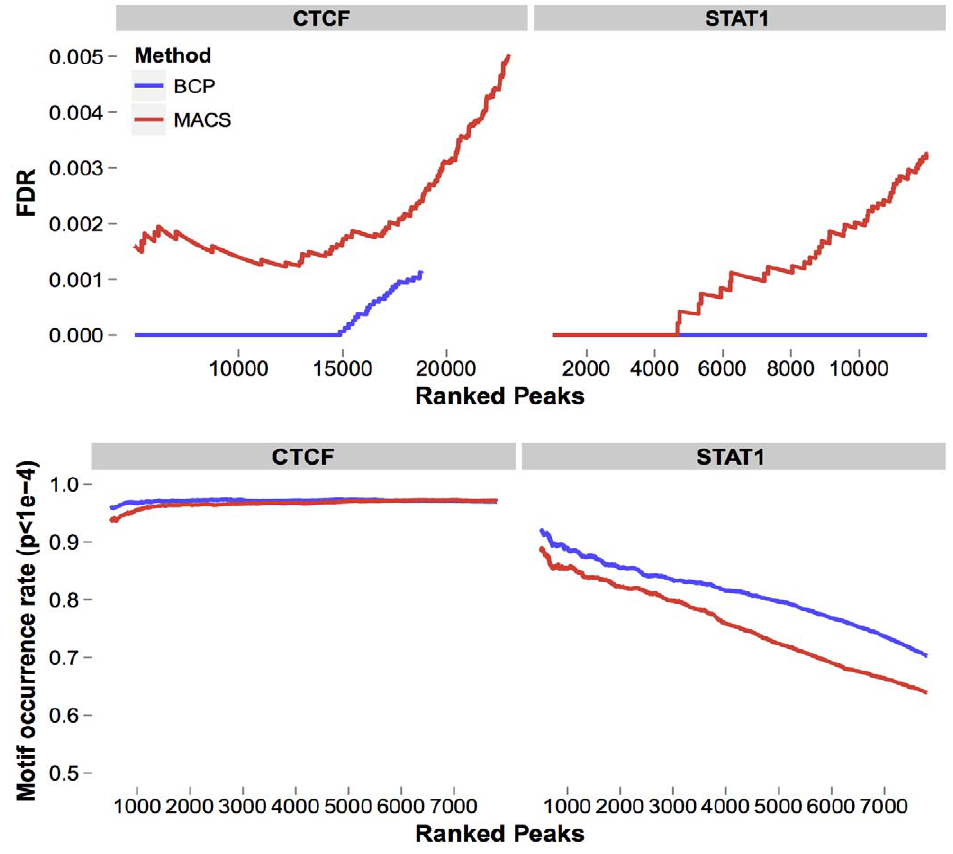
Figure 5. BCP showed strong performance in punctate transcription factor ChIP-seq data. Compared to MACS, a representative peak- calling algorithm designed for punctate peaks detection, BCP showed a comparable false-discovery rate (FDR) and rate of motif occurrence in both CTCF and STAT1 datasets. We apply the empirical FDR described in the Methods and by [17], dividing the negative peaks (detected when the input control sample was set as the test and the ChIP sample was set as the control) by the number of test peaks (the ChIP sample was set as the test and the input control sample was set as the control). Peaks are ranked according to p-value. Additionally, BCP displayed a slightly improved motif occurrence rate (the fraction of peaks containing a match to the TRANSFAC consensus motifs, as determined by STORM, p v 10 { 4